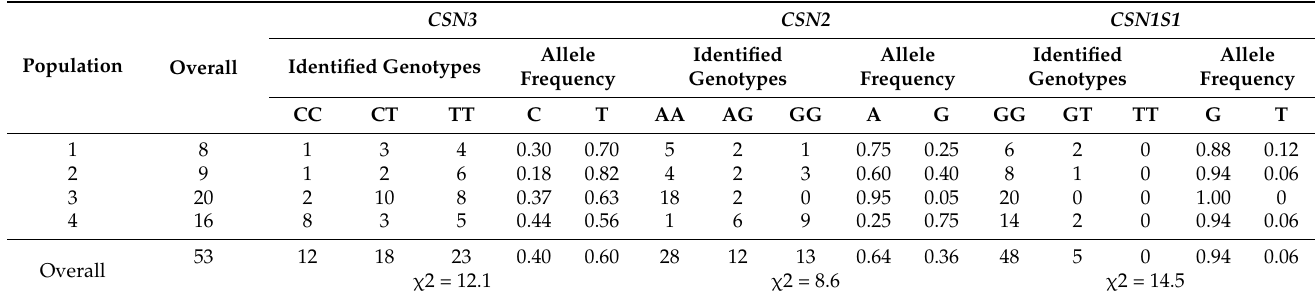
Table 2. CSN3 , CSN2 , and CSN1S1 genes polymorphism